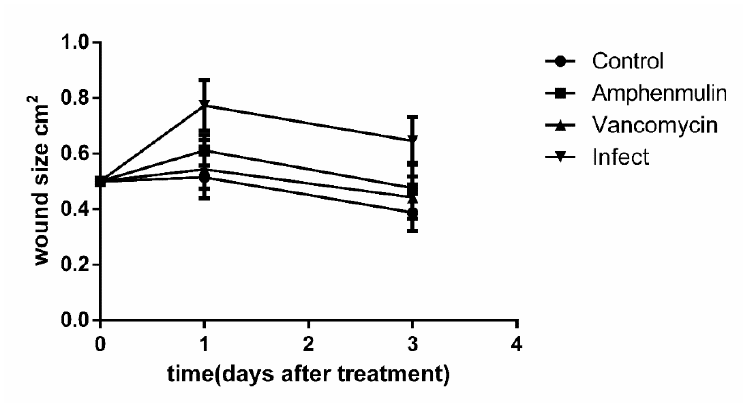
Figure 5. Wound size at one and three days after treatment.